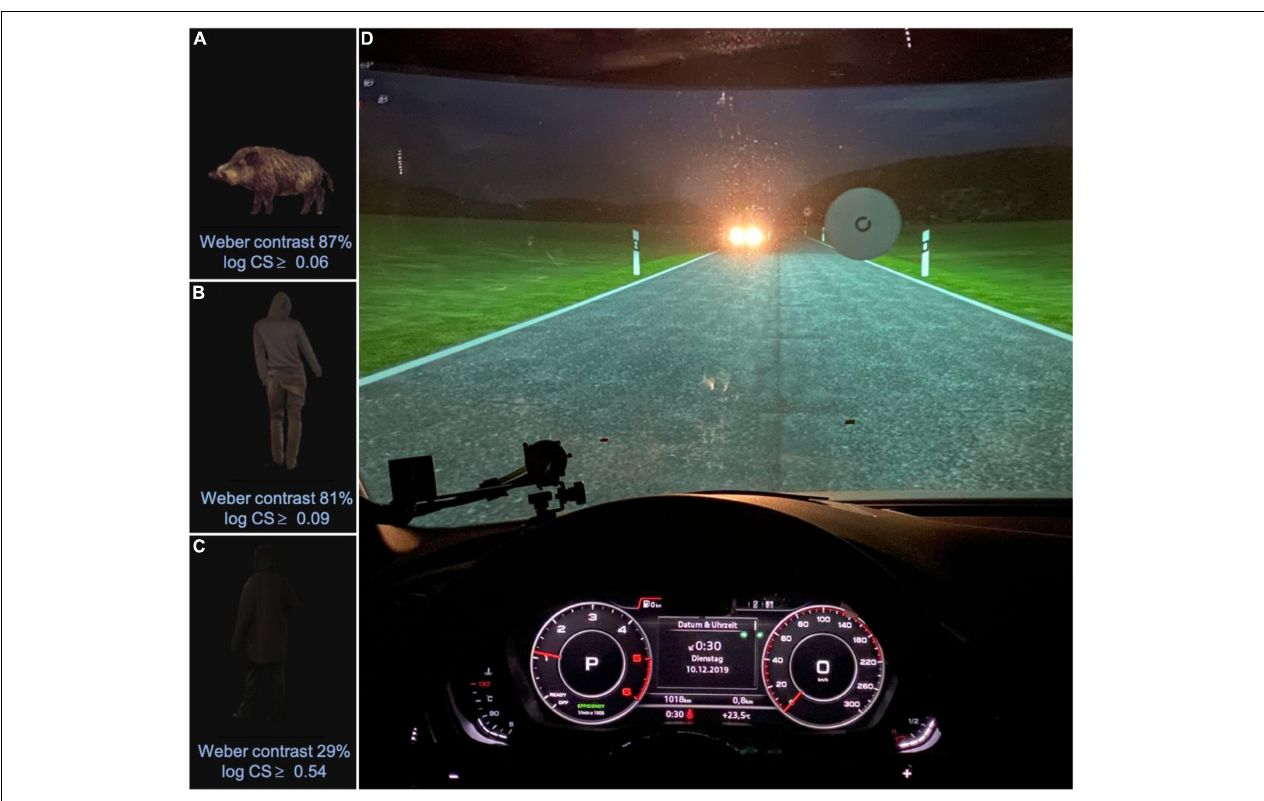
FIGURE 1 | The night driving simulator (D) and associated hazards (A–C) . Hazard in Panel (C) may be difficult to see owing to its low contrast. Visible in Panel (D) is one of the Landolt Cs used to measure CS within the simulator, as well as the dipped headlights of the oncoming vehicle, which were simulated by LEDs physically moved by cable robots. The digital dashboard was fully functional and provided realistic feedback during simulated driving. Realistic auditory feedback (engine noises) was also provided. See main manuscript text for further technical details regarding the simulator. Note that when capturing the photograph shown in panel (D) , some overexposure was required to visualize the instrument panel and compensate for the veiling glare of the oncoming virtual car. As a result, some subtle but important aspects of the lighting may not be apparent. For example, car headlights have an asymmetrical light distribution (to minimize glare to oncoming cars). So in the scene depicted here, the righthand side of the road immediately in front of the simulated car should have a more intense luminance distribution than the left. Likewise, the forward light from the simulated vehicle should decrease with eccentricity and distance from the participant. All of these details were in fact the case, but are not obvious from inspection of the photograph (e.g., apron luminance was between 1.3 and 2 cd/m2 for the right roadside, varying as a function of distance, and between 0.6 and 1 cd/m2 for the